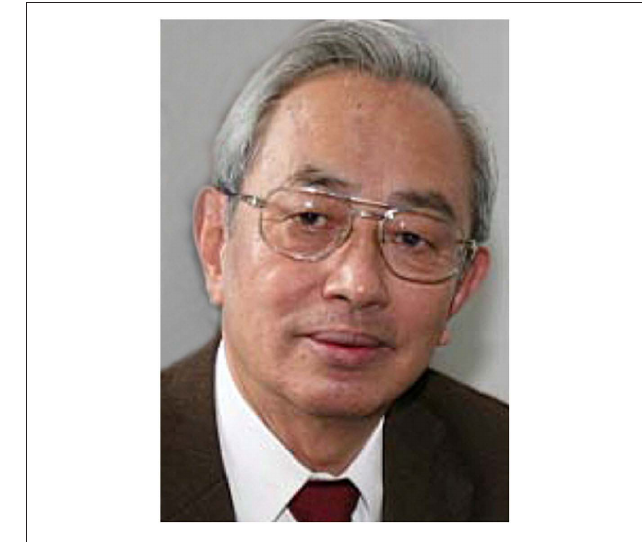
Figure 1 | Ganoderma lucidum (Leyss. ex Fr.) Karst. Figure 2 | Professor Zhi-Bin